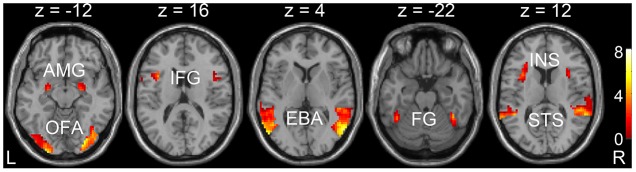
Localizations of regions of interest (ROIs) at the group level. Localization was considered set for an ROI when p < 0.05, and with cluster corrections with a minimum extent of 10 voxels. AMG, amygdala; IFG, inferior frontal gyrus; OFA, occipital face area; EBA, extrastriate body area; STS, superior temporal sulcus; FG, fusiform gyrus; INS, insula.